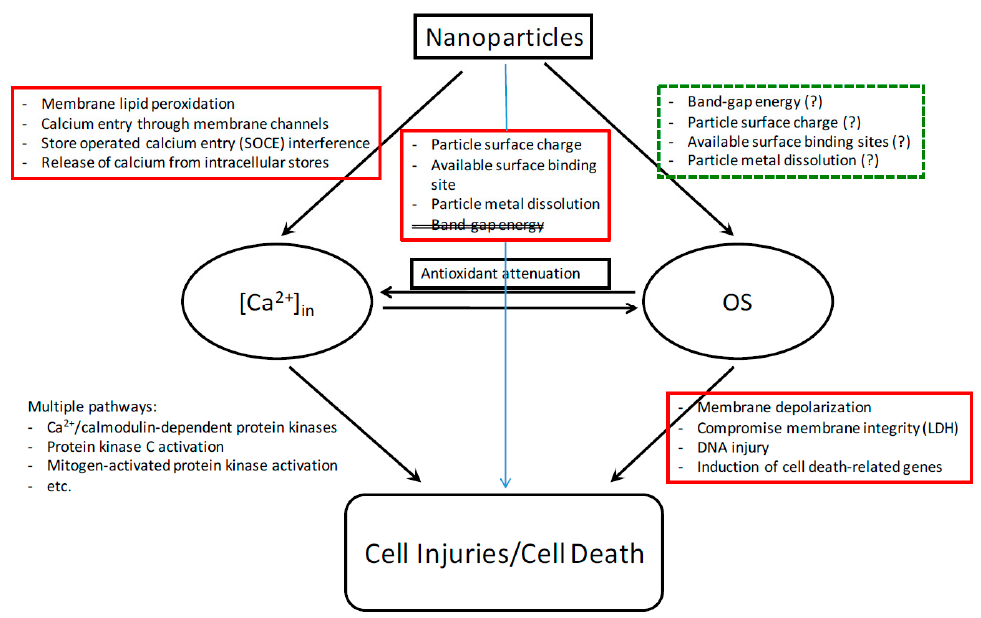
Figure 2. Multiple mechanisms of nanoparticle toxicity contribute to cell cycle deregulation and cell death. Particles used to delineate the pathways include Al 2 O 3 , SiO 2 , CeO 2 , and transition metal oxides.